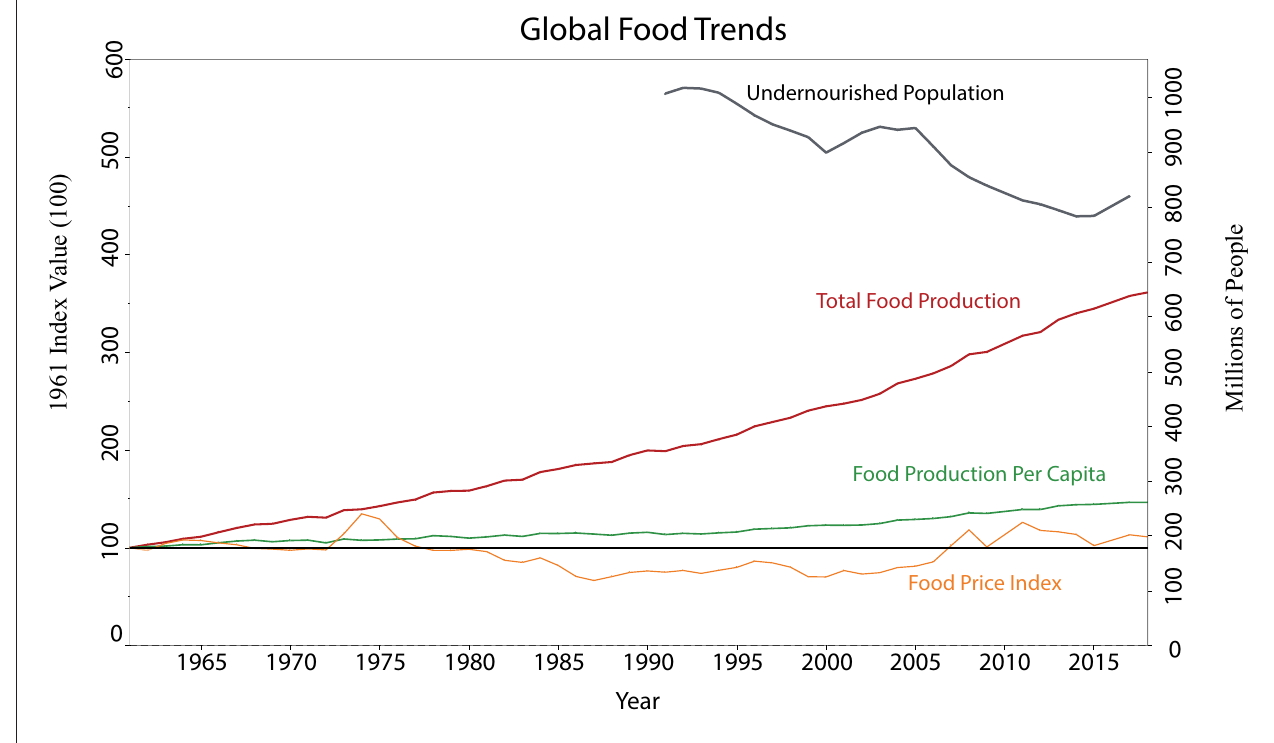
FIGURE 1 | Trends in global food systems illustrate global successes in producing more food every year, both in total and per-capita, while keeping food prices relatively stable (left axis). Undernourishment has dropped modestly during this period but remains a significant problem (right axis). Food production data are standardized to a 1961 index value of 100. See the Supplementary Material for source